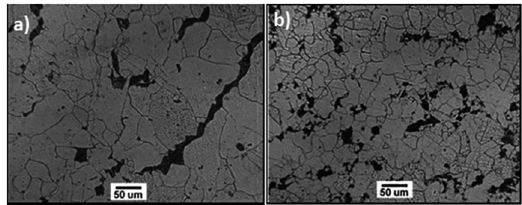
Figure 2. The figures show the microstructures of the annealed steels containing 0.01 (a) and 0.08 Nb (b). In the second, the grains are smaller because the higher niobium content (Nital 2% - COM).